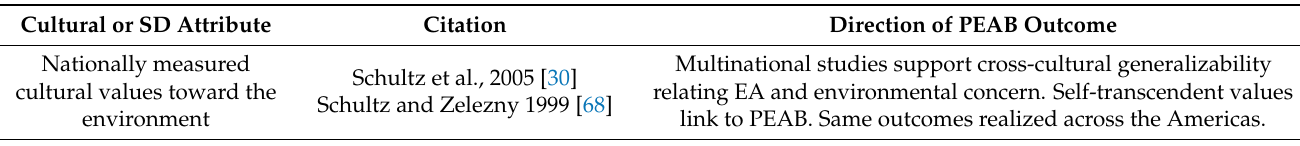
Table 4. Studies associating specific cultural and sociodemographic attributes with PEAB